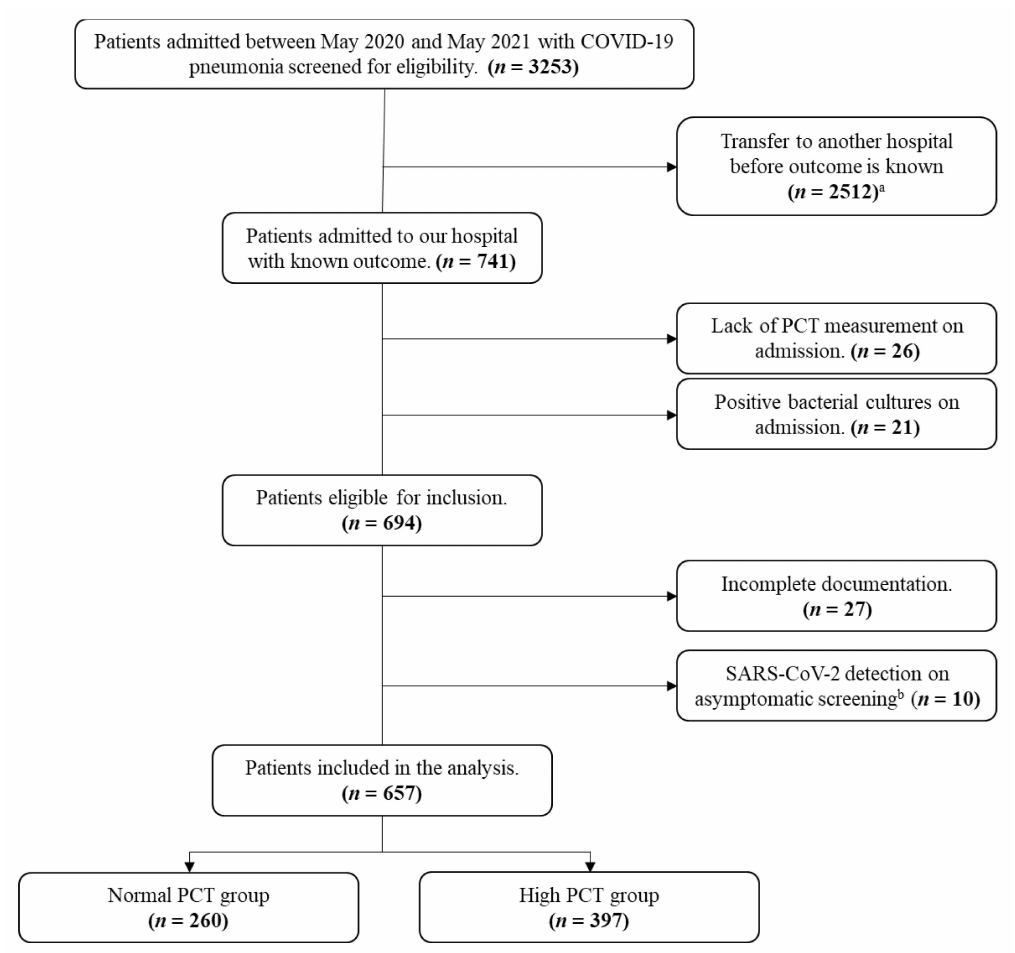
Figure 1. Flowchart demonstrating the patient selection process. Abbreviations: COVID-19, coron- avirus disease 2019; PCT, procalcitonin; SARS-CoV-2, severe acute respiratory syndrome coronavirus- 2. a Transfer of patients to a tertiary dedicated COVID-19 center, to decrease the burden on the district hospitals, was regularly arranged by the national health authorities during the pandemic. b Patients who were discovered positive on screening and referred to the medical COVID-19 ward for isolation only without evidence of